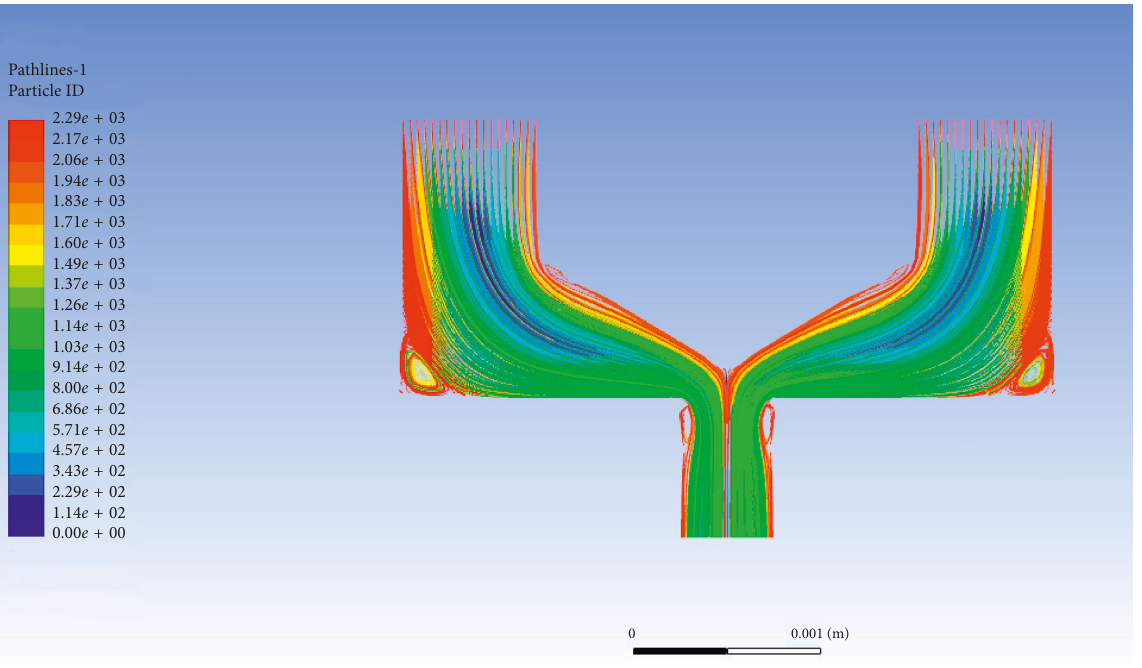
Figure 27: Flow streamline when the poppet valve core angle is 120 ° .